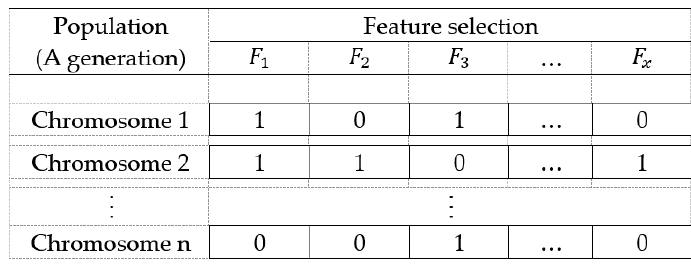
Figure 3. Structure of chromosomes.